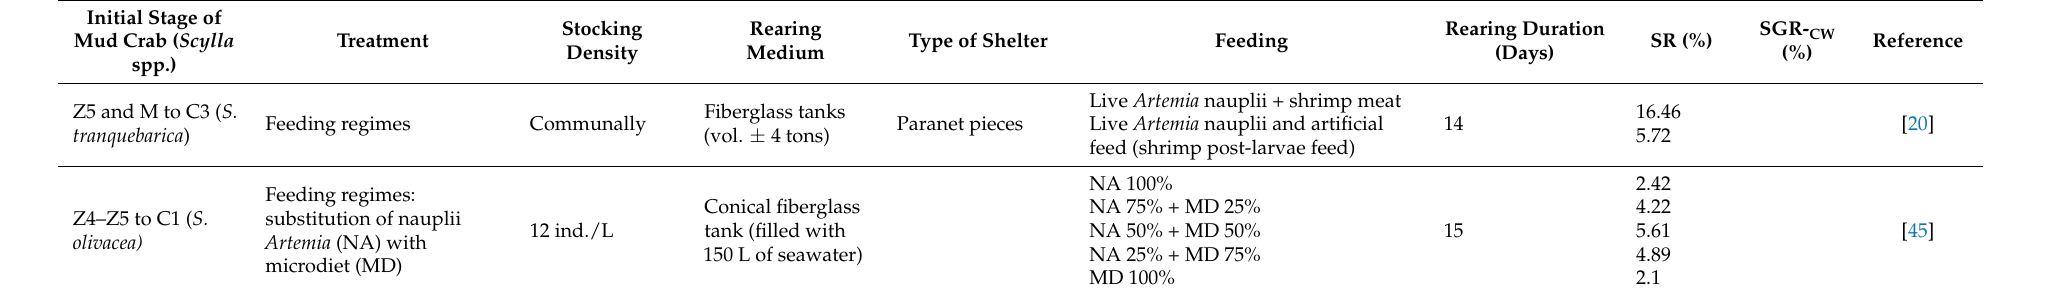
Initial Stage of Mud Crab ( Scylla